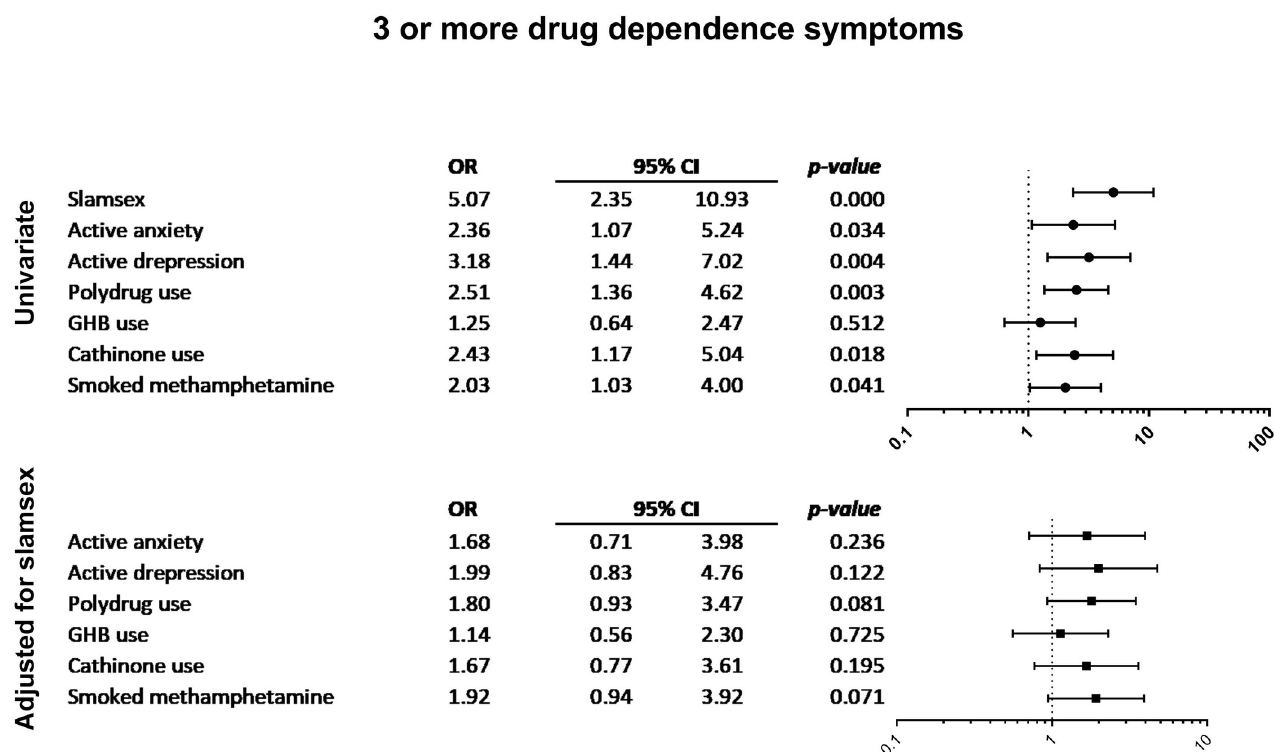
Fig 2. Association between current self-reported psychiatric diagnosis and 3 or more drug-dependence symptoms.